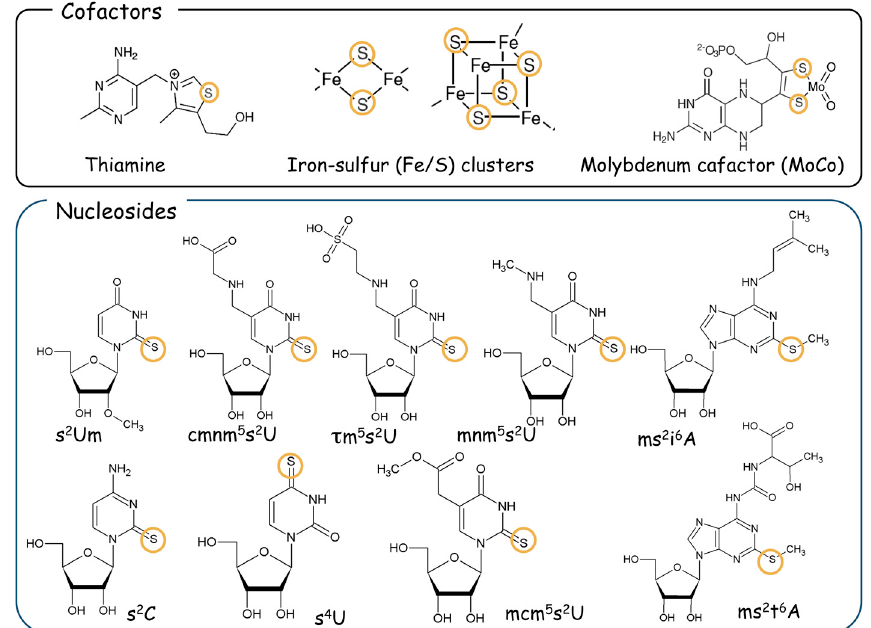
Figure 1. Sulfur ‐ containing small molecules. Many biocofactors such as thiamine, iron ‐ sulfur (Fe/S) clusters, and molybdenum cofactor (MoCo) contain sulfur atoms in their structure (upper column). Various sulfur ‐ containing nucleosides are also identified. For example, the 2 ‐ thiocytidine derivatives are 2 ‐ thiocytidine (s 2 C) found in bacteria and 2 ‐ thio ‐ 2 ′‐ O ‐ methyluridine (s 2 Um) found in humans. 4 ‐ thiouridine (s 4 U) is found in bacteria. Various types of the hyper ‐ modified uridine, such as 5 ‐ carboxymethylaminomethyl ‐ 2 ‐ thiouridine (cmnm 5 s 2 U), 5 ‐ methylaminomethyl ‐ 2 ‐ thiouridine (mnm 5 s 2 U), 5 ‐ taurinomethyl ‐ 2 ‐ thiouridine ( τ m 5 s 2 U), and 5 ‐ methoxycarbonylmethyl ‐ 2 ‐ thiouridine (mcm 5 s 2 U) are found at U 34 . Various methylthio ‐ adenosine derivatives, such as 2 ‐ methylthio ‐ N 6 ‐ isopentenyladenosine (ms 2 i 6 A) and 2 ‐ methylthio ‐ N 6 ‐ threonylcarbamoyladenosine (ms 2 t 6 A), are also found in both bacteria and eukaryotes. Sulfur atoms incorporated into the molecule in the biosynthetic pathway are shown with circles.